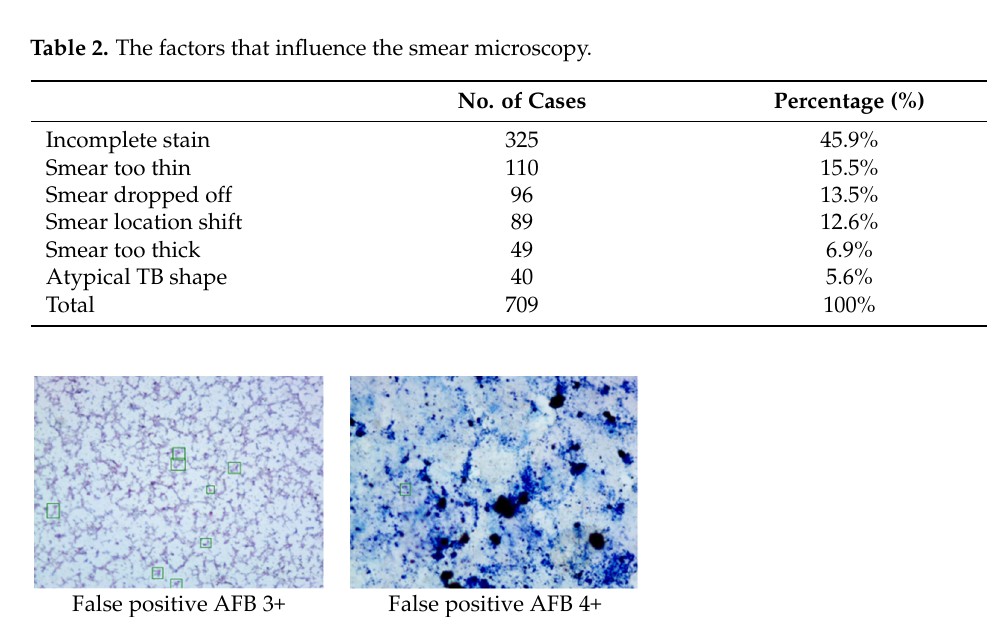
Figure 4. The two false-positive cases due to the poor smear staining quality.